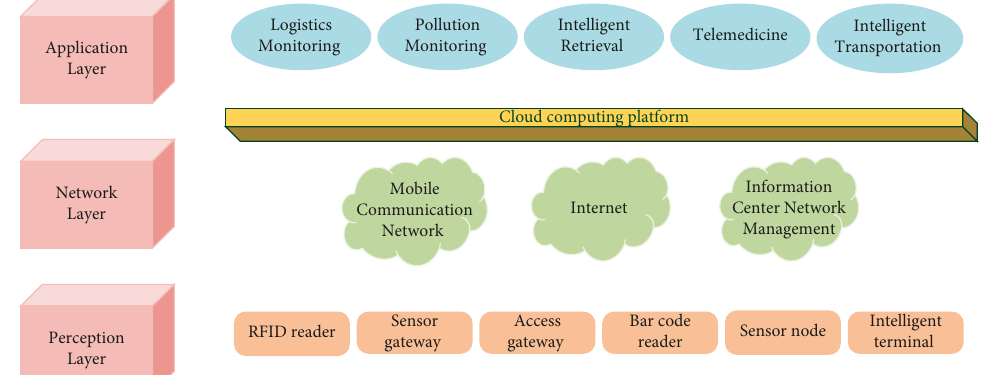
Figure 1: Architecture of the